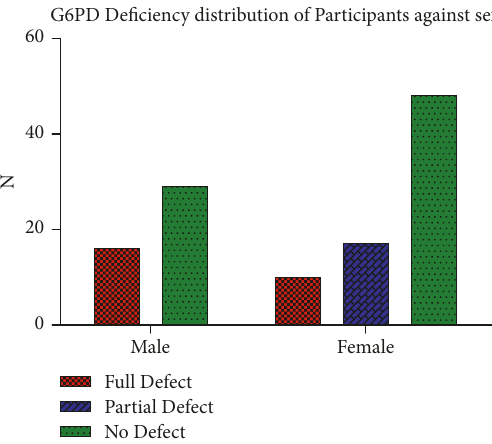
Figure 3: The figure represents G6PD deficiency (full and partial) and G6PD normal among the